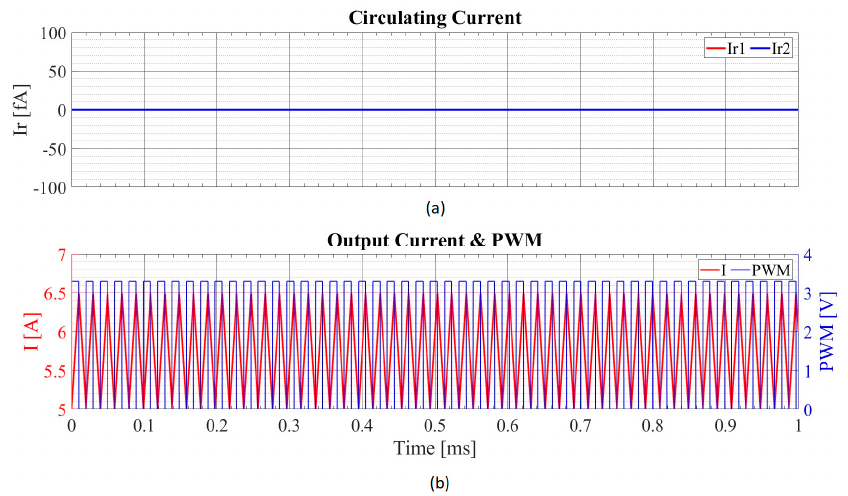
Figure 8. Simulations with two parallel-connected inverters: ( a ) circulating current seen by the two inverters; the zero value obtained shows the validity of the algorithm; ( b ) PWM waveform and output current.